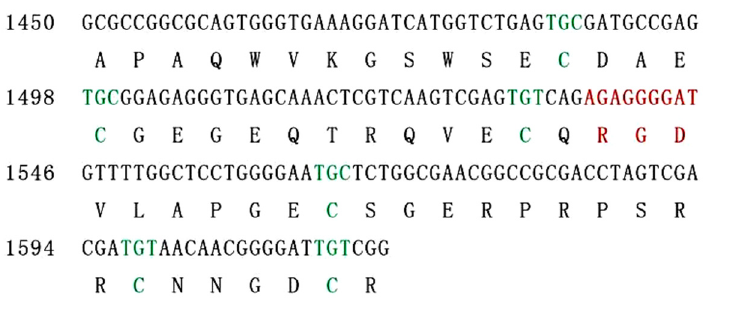
Figure A2. Nucleic-acid (upper lines) and amino-acid (lower lines) sequences of the third TSP1 domain (Aj-Tspin) in the ADAMTS13-like sequence from A. japonicus . Green indicates cysteine residues (lower lines) and their nucleic-acid (upper lines). Red indicates the nucleic-acid (upper lines) and amino-acid (lower lines) of the RGD motif.